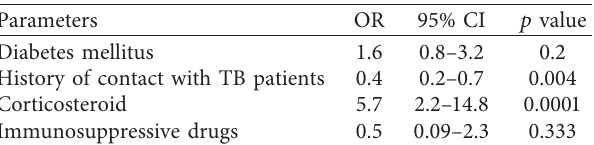
Table 6: Independent predictors for the development of